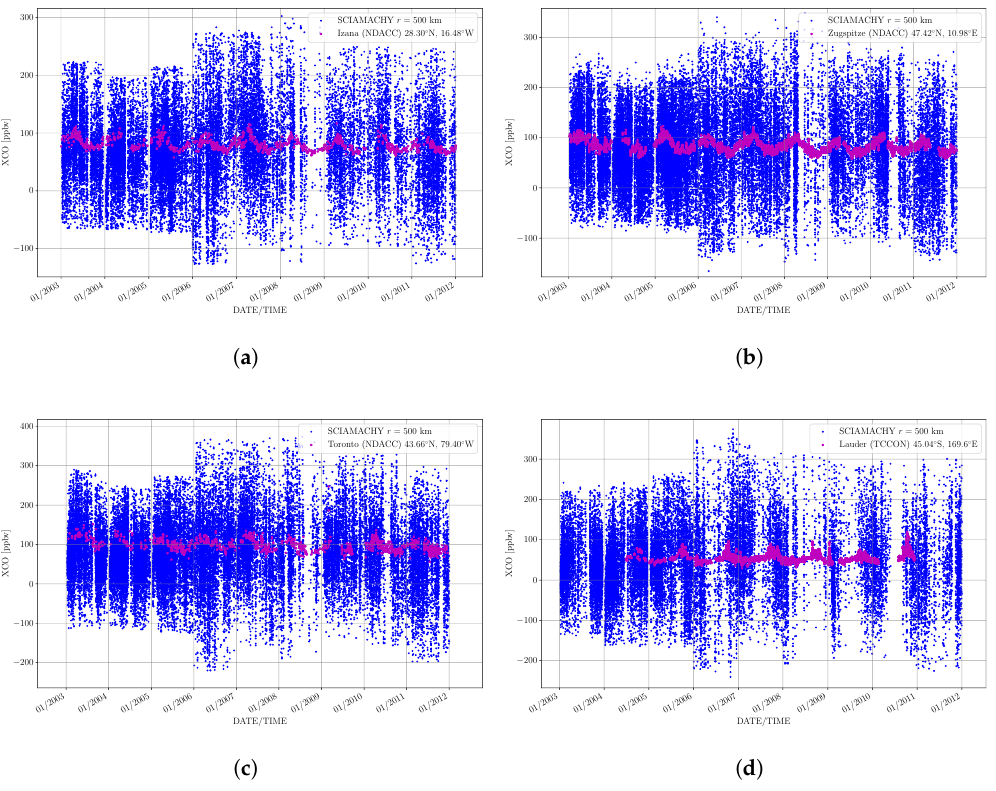
Figure 2. The SCIAMACHY and g-b reference site dry air column mixing ratios of carbon monoxide (xCO). The plot includes the column mixing ratios (CMRs) after postprocessing within 500 km of the reference sites ( a ) Izana, ( b ) Zugspitze, ( c ) Toronto and ( d ) Lauder from 2003 to 2011. The large scatter of the individual SCIAMACHY CO columns is mainly caused by measurement noise, while averaging of observations within 500 km of the reference site has only a minor